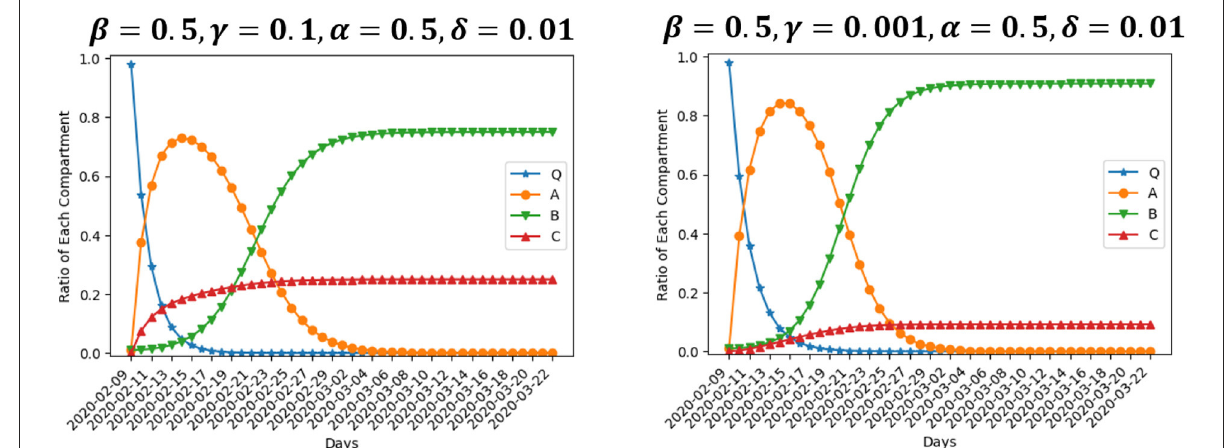
FIGURE5 Simulation using different values of γ .